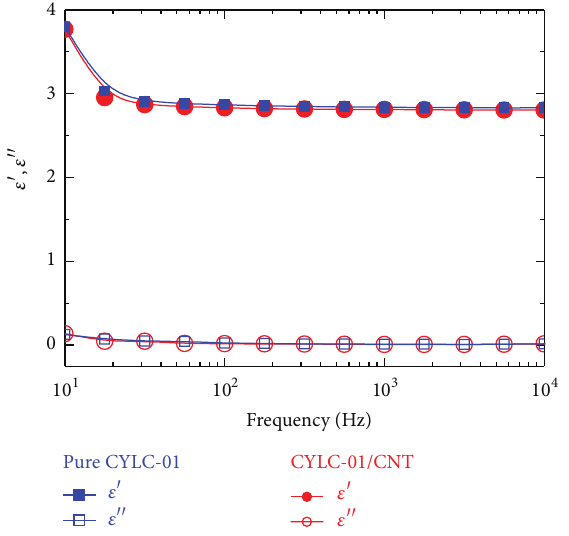
Figure 3: The dielectric spectra of pure and 0.05wt% CNT-doped E7 in homogeneous cells at 303 K.